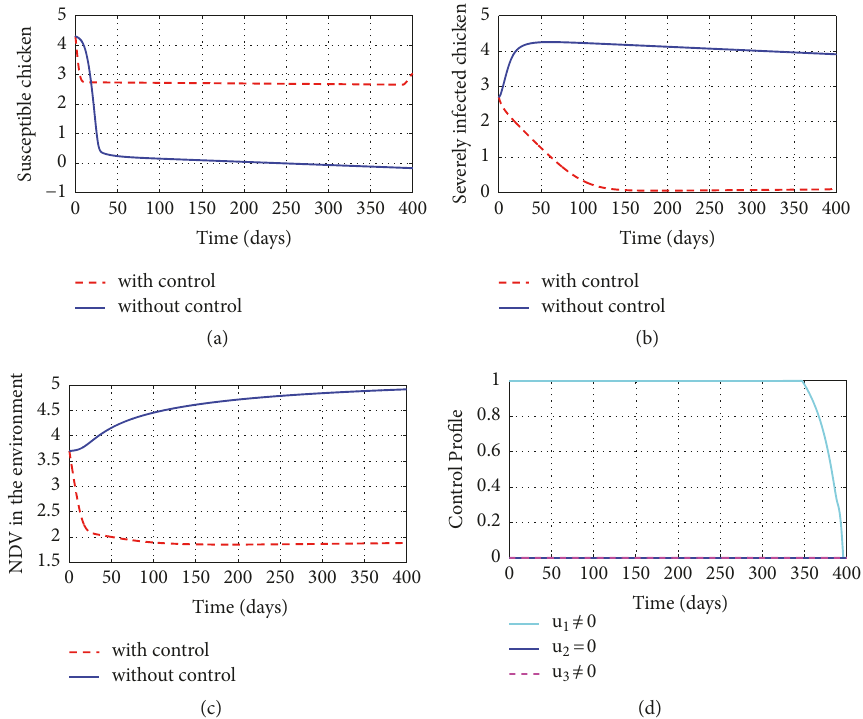
Figure 5: Optimal solutions for model variables 𝑆 𝑐 , 𝐼 𝑐 , 𝐻 and the control profiles for 𝑢 1 , 𝑢 2 , 𝑢 3 with ( 𝑢 1 ̸= 0 , 𝑢 2 = 0 , 𝑢 3 ̸= 0 ).